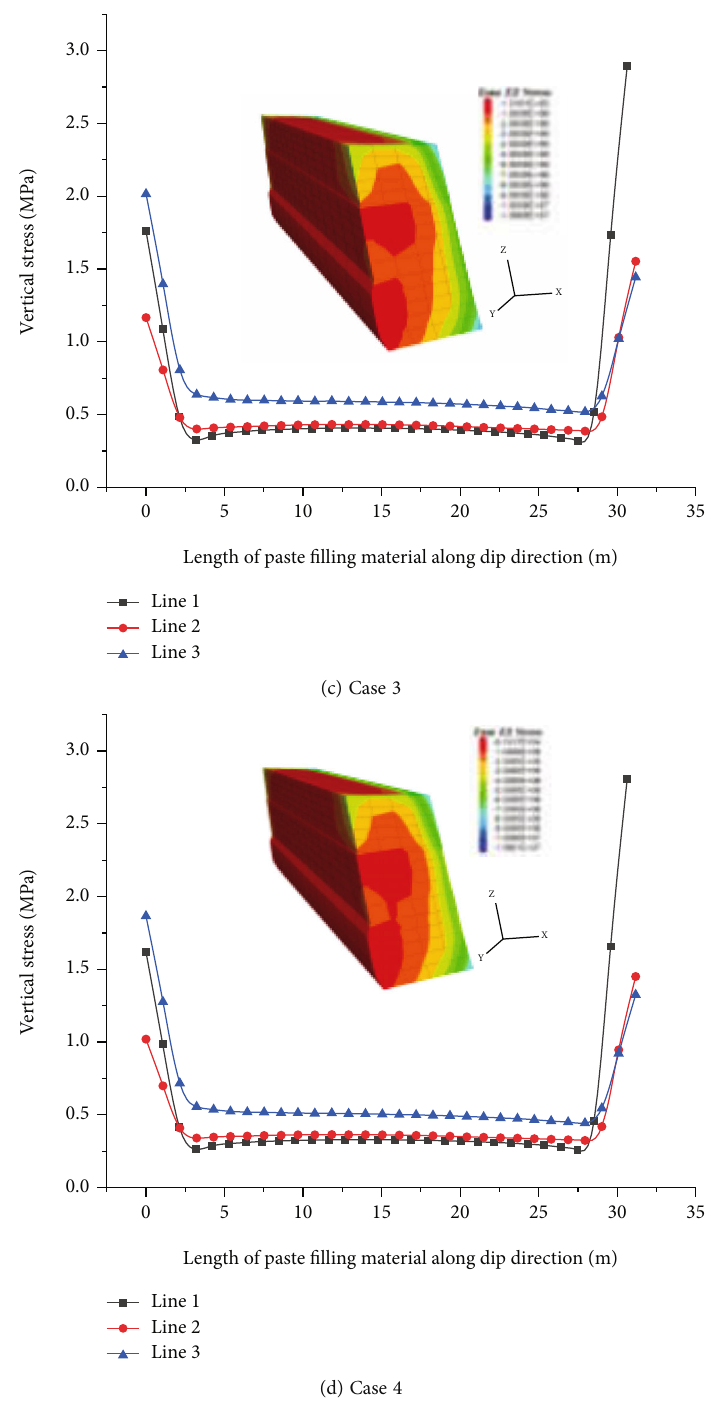
Figure 10: Vertical stress distribution of back fi ll before